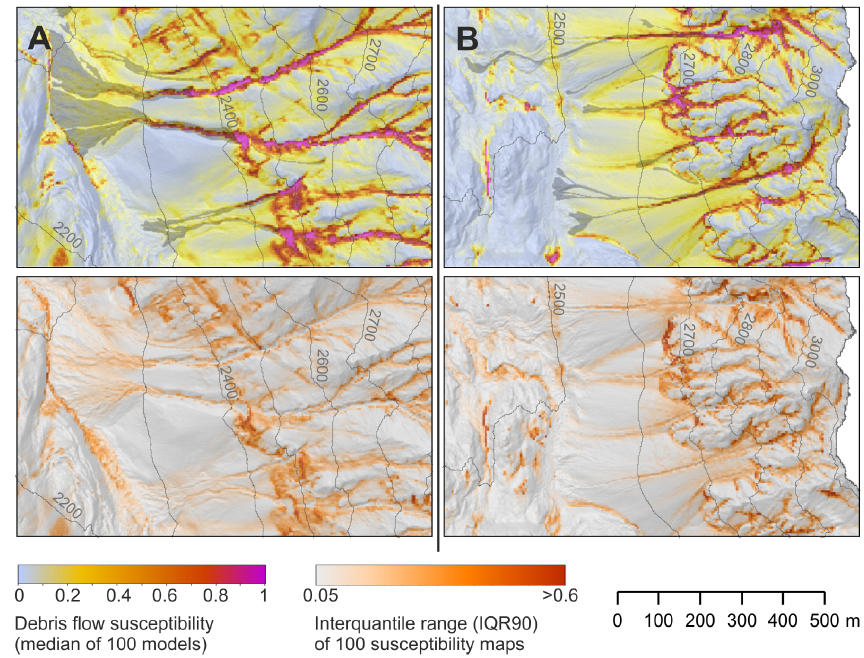
Fig. 7. Map sections (for full extent, see Supplement) from the ZBT (B) and LT (A) areas. The maps show the susceptibility map (see Fig. 6) and a map of the IQR90 calculated from the model ensemble. The latter map represents the uncertainty of the susceptibility map that is due to the sampling